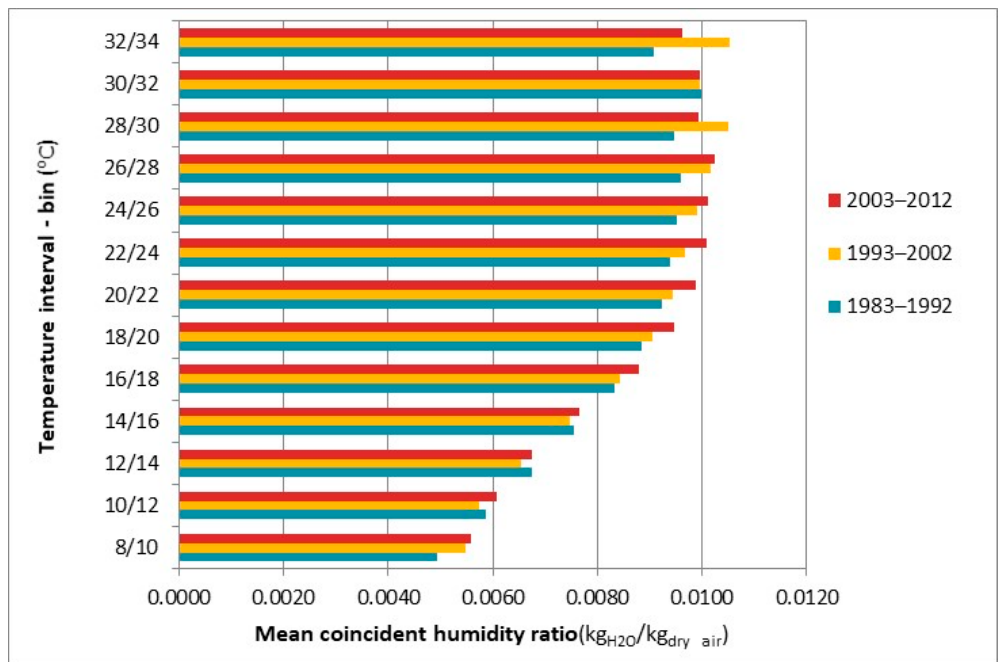
Figure 7. Mean coincident humidity ratio, in 2 °C temperature intervals, Athens (NOA) (transitional months—October and May).